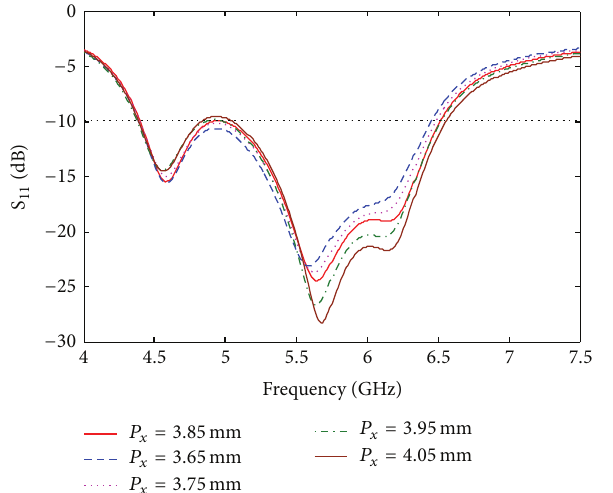
Figure 6: Frequency behavior of the magnitude of the reflection Figure 4: Frequency behavior of the magnitude of the reflection coefficients as a function of the outer diameter 𝑅 coefficients as a function of the feed position 𝑃 𝑥 with 𝑊 = 2.35 mm, 𝐿 = 21.79 mm, 𝑅 2.35 mm, 𝐿 = 21.79 mm, 𝑃 𝑥 = 3.85 mm, 𝑅 = 15.29 mm, 𝑅 = 20.22 mm, 𝑅 = 8.70 mm, in 1 out 1 in 2 = 10.09mm. 8.70 mm, and 𝑅 = 10.09 mm. and 𝑅 out 2 out 2